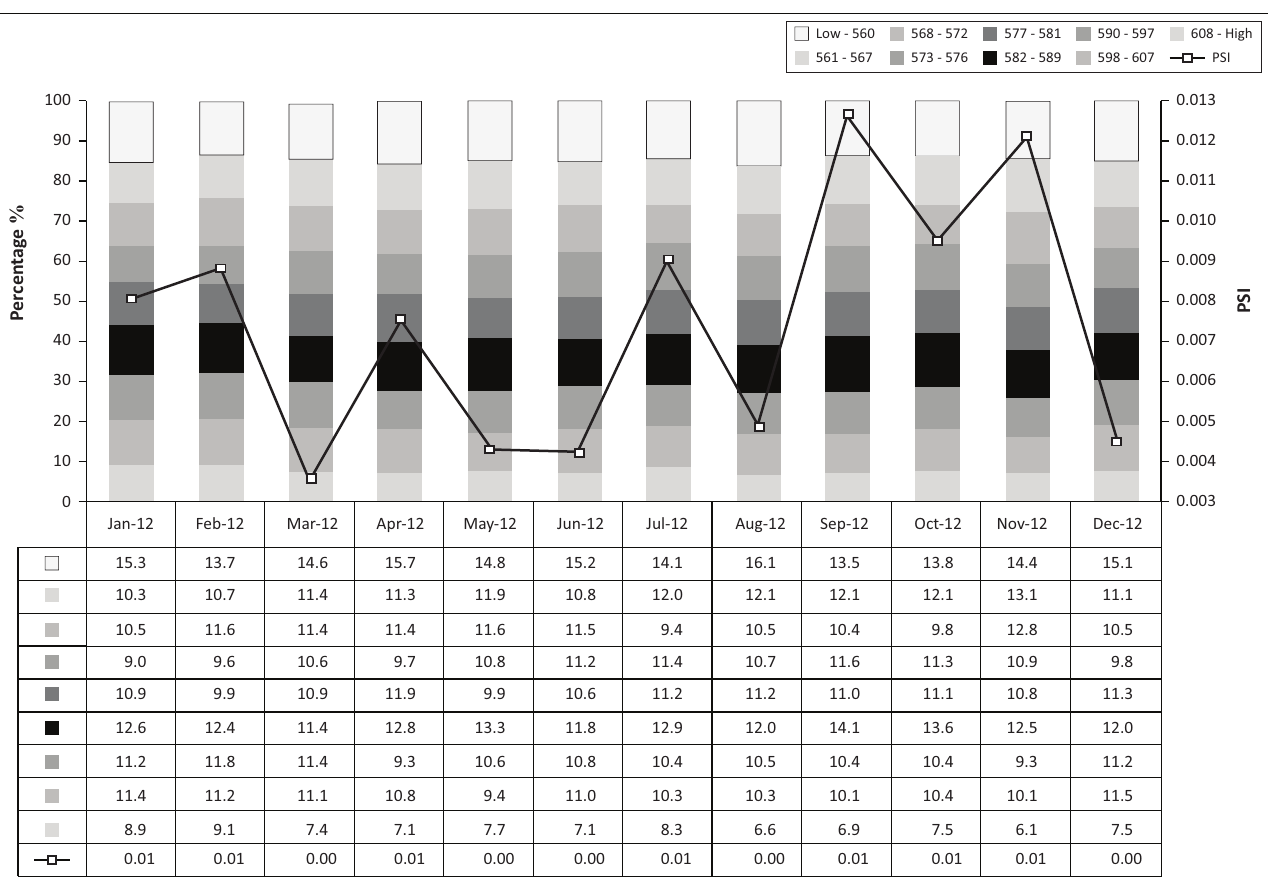
FIGURE 9: Population stability index.